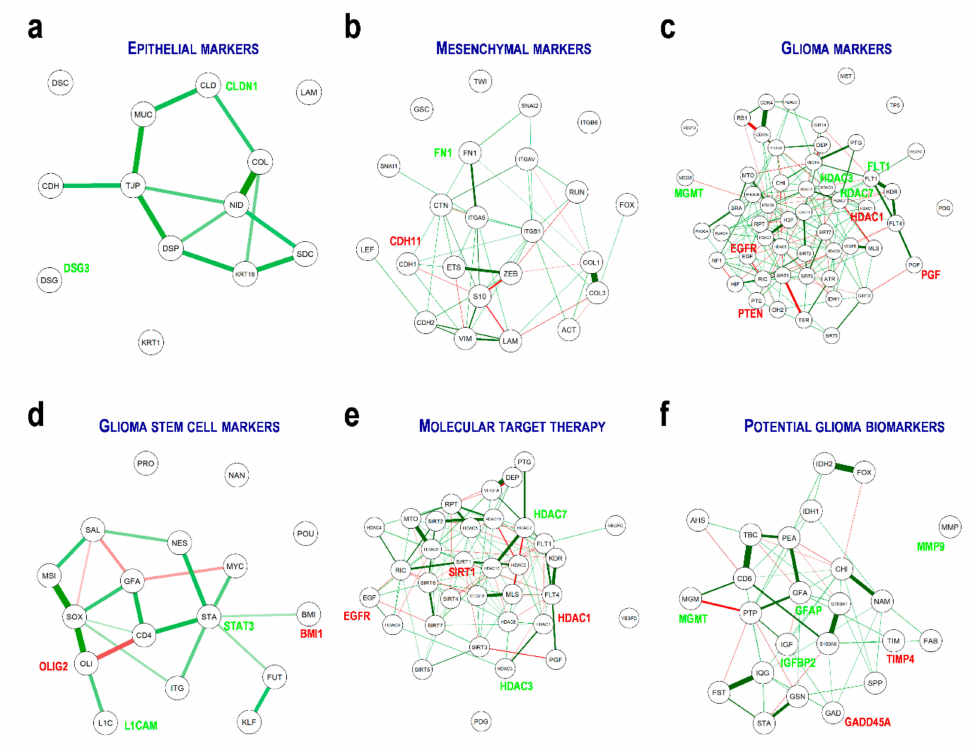
Figure 3. Genetic interaction networks based on the gene expression within the gene sets in glioblastoma. The graphical lasso estimation of the network models is drawn. ( a ) Epithelial marker gene set. ( b ) Mesenchymal marker gene set. ( c ) Glioma marker gene set. ( d ) Glioma stem cell marker gene set. ( e ) Molecular target therapy gene set. ( f ) Potential glioma marker gene set. The genes with significant hazard ratios are highlighted. Red and green represent poor and good prognosis,